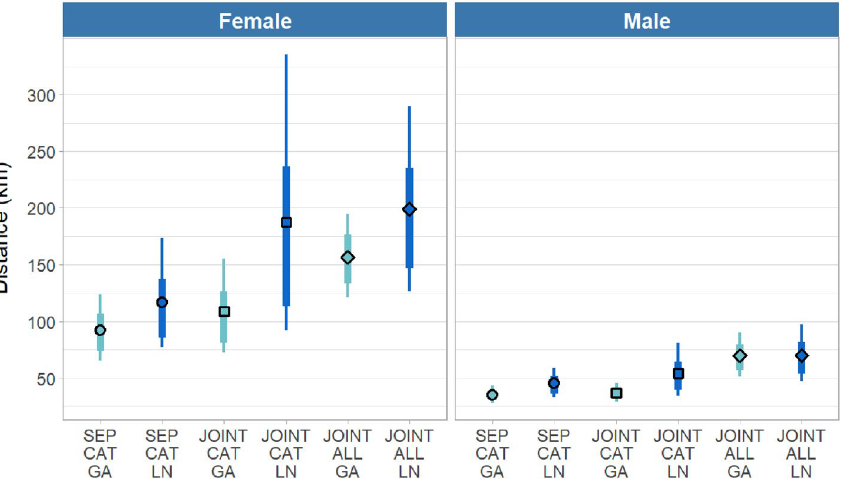
Figure 1. Average natal dispersal distance (km) by model, sex, and distribution (gamma: GA, lognormal: LN). Circles and squares indicate median values. Thick lines indicate the 66% HPDI and fine lines show the 89%